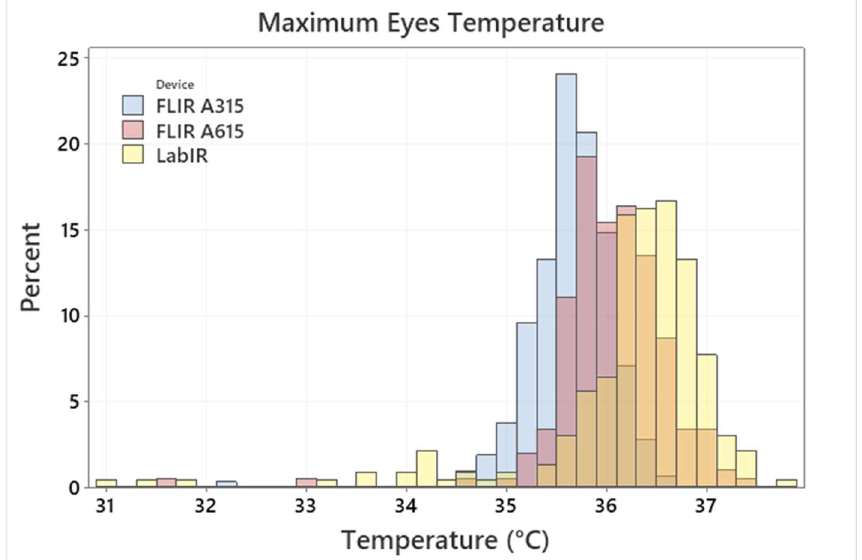
Figure 7. Maximum eyes temperature by the FLIR A315/615 and LabIR IR cameras histogram distributions. (The diagram represents combination of histograms of 3 devices, 3 colors in the legend indicate 3 individual devices. Other colors in the graph represent overlaps.)